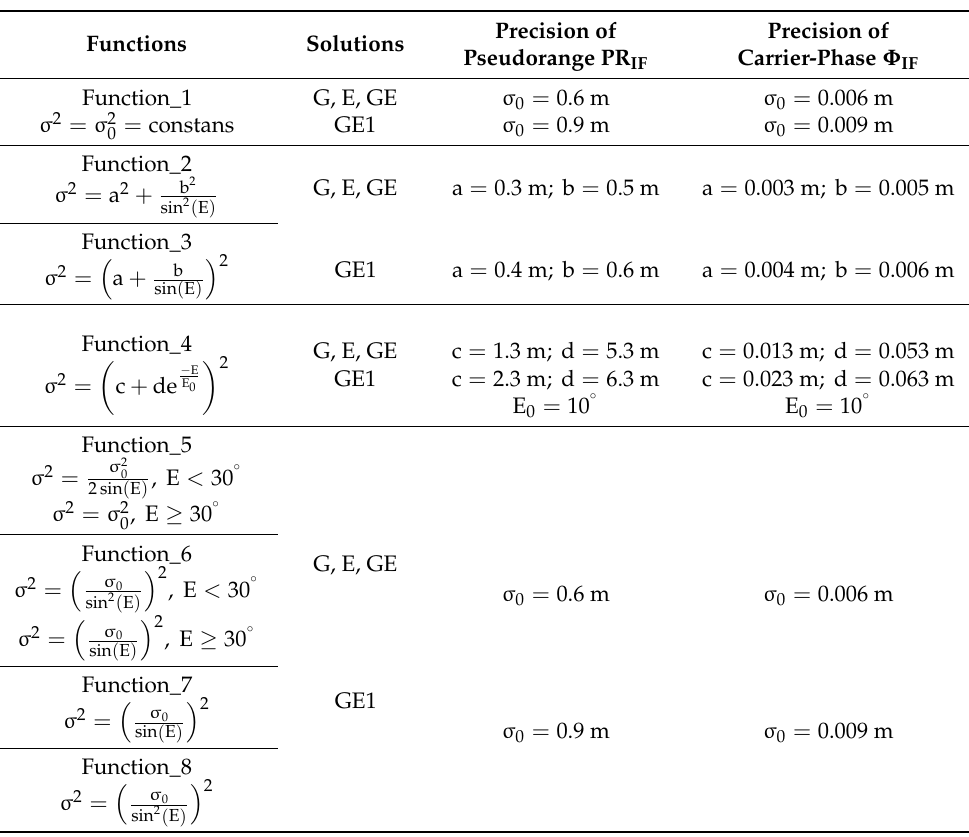
Table 2. Used weighting